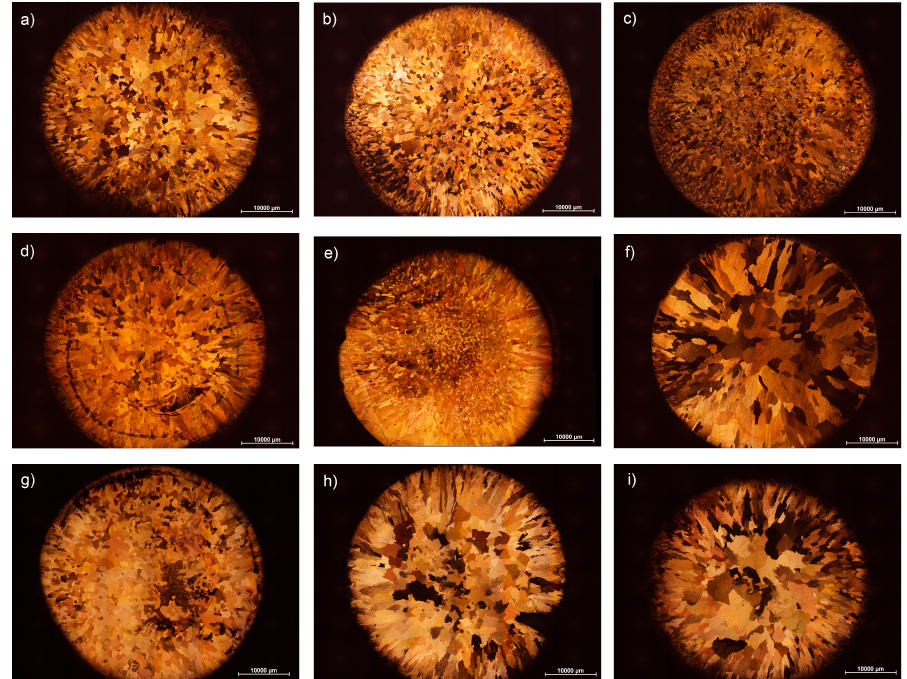
Figure 6. Macrographs of Cu–Te, Cu–Ti and Cu–Zr TP-1 samples. ( a ) 0.001 wt % Te, ( b ) 0.013 wt % Te, ( c ) 0.564 wt % Te, ( d ) 0.014 wt % Ti, ( e ) 0.058 wt % Ti, ( f ) 0.708 wt % Ti, ( g ) 0.012 wt % Zr, ( h ) 0.182 wt % Zr, and ( i ) 0.398 wt % Zr. Macrographs ( g ) and ( i ) are reprinted with permission from [32], Taylor and Francis Ltd., 2017.